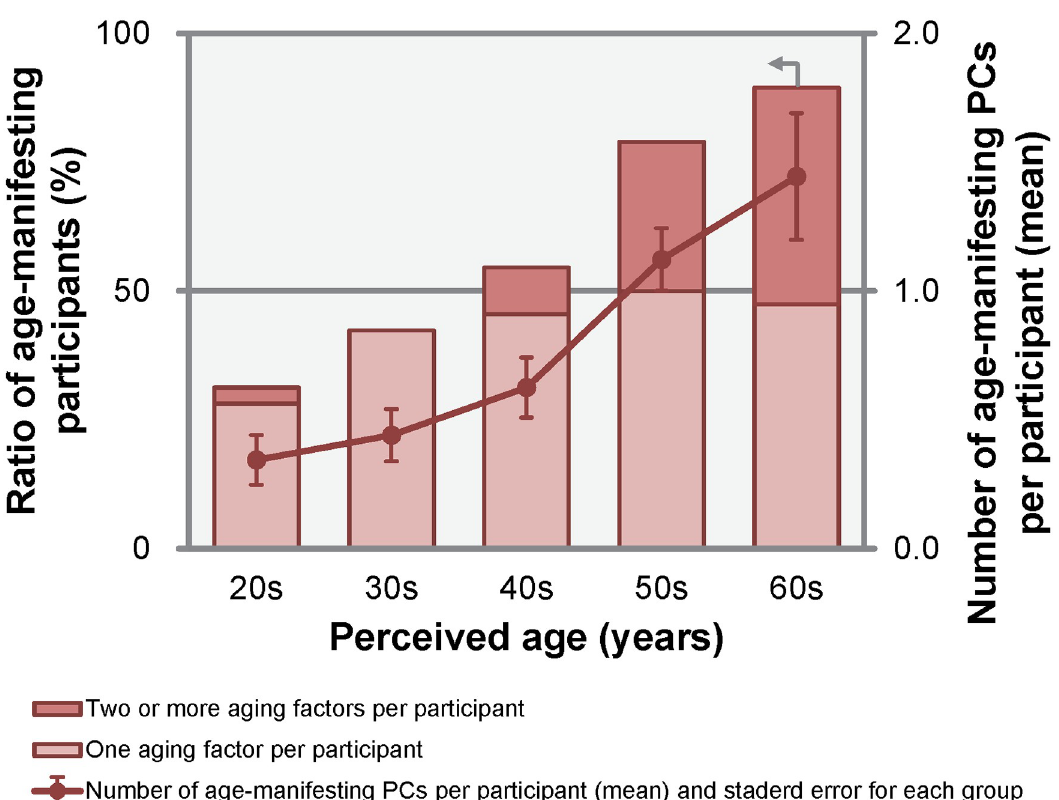
Fig 5. Ratio of age-manifesting participants a in each age cohort and number of age-manifesting principal components (PCs) b . a Participants who had one or more age-related PC score greater than +1.0 σ in the age-related direction. b Age-related PCs scores greater than +1.0 σ in the age-related direction (bars represent standard